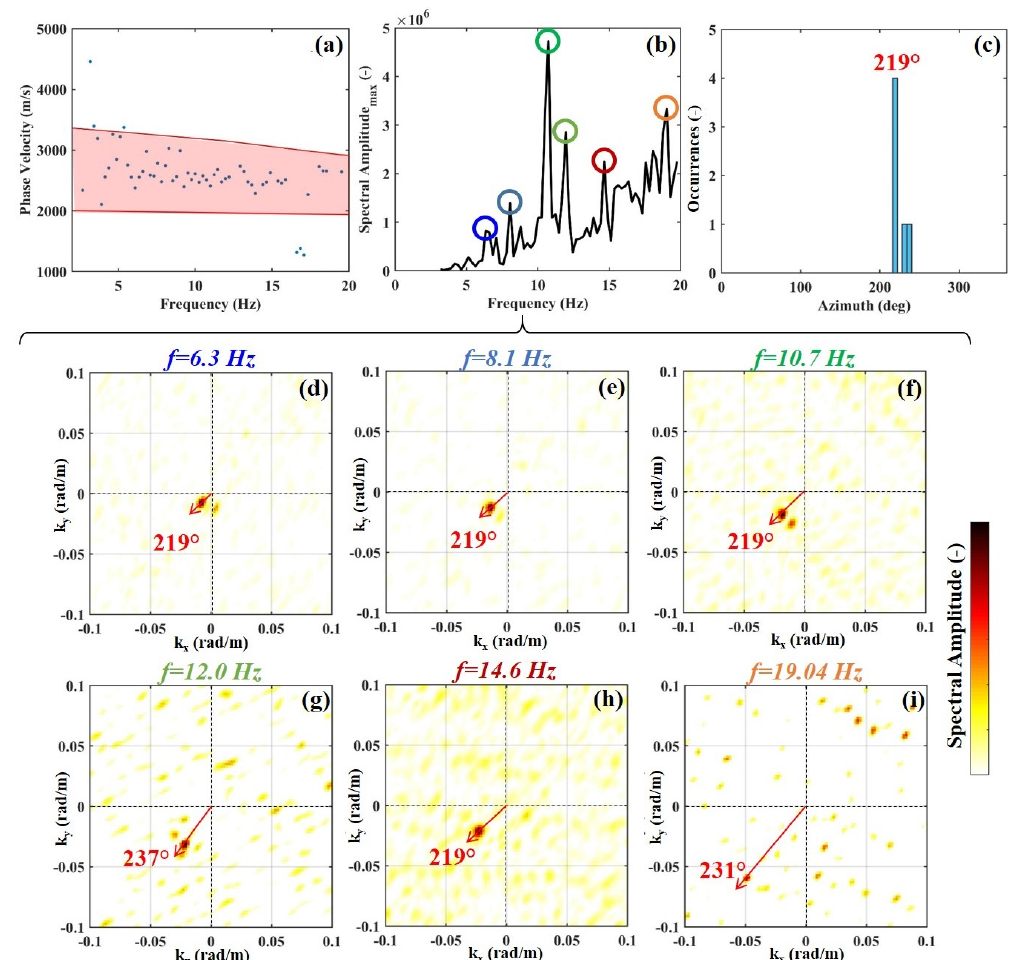
Figure 3. Example of frequency-domain beamforming (FDBF) computation on a 2s window. (a) DC from the FDBF method compared to the reference dispersion region (in red, from active dispersion data, Da Col et al., 2020). (b) Spectral amplitude of the maxima in the k x – k y planes (related to different frequencies). Colored circles refer to the peaks whose k x – k y planes are shown in (d) to (i) . (c) Histogram of the azimuth occurrences in the analyzed k x – k y planes. (d–i) k x – k y planes at different frequencies with azimuth computations (degrees counterclockwise from E, green reference system in Fig.